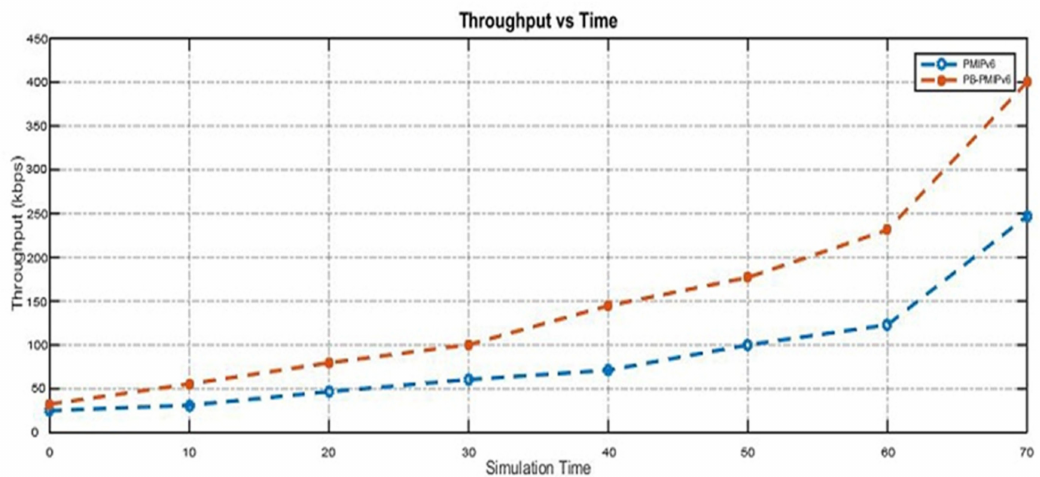
Figure 11. Comparisons of throughput vs time.